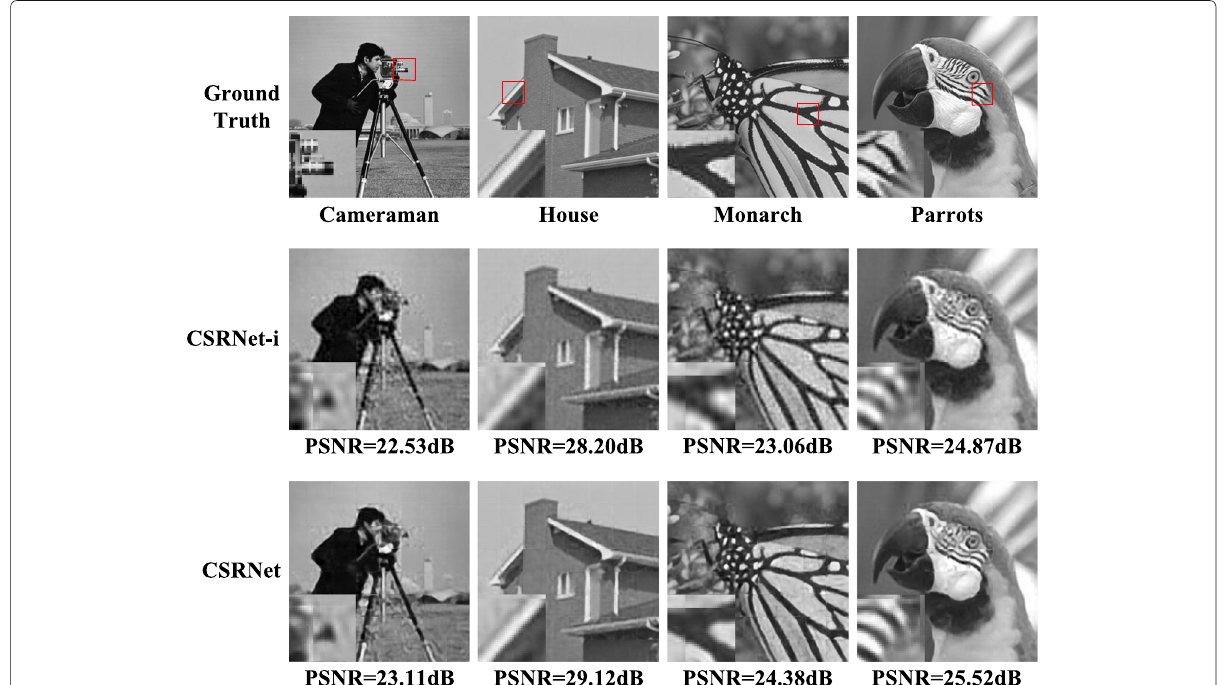
Fig. 17 The intermediate and final reconstruction results of CSRNet at the measurement rate 0.20